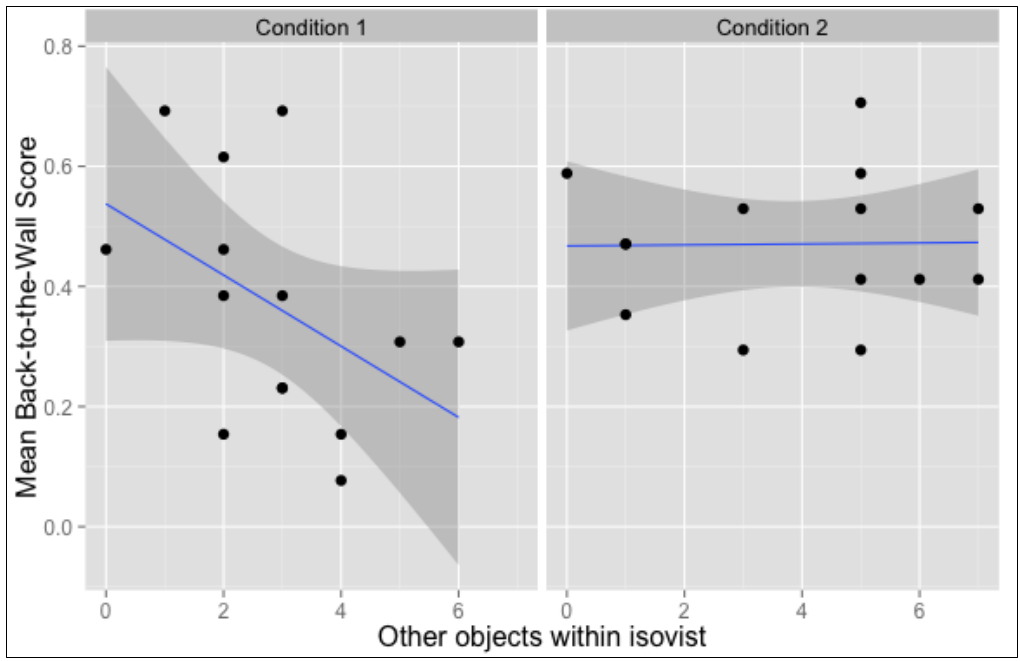
Figure 8. Location-based correlations for Back-to-the-Wall Score and the number of other objects within location’s isovist. Data points represent locations (x101-x114 for Condition 1 and x201-x214 for Condition 2).